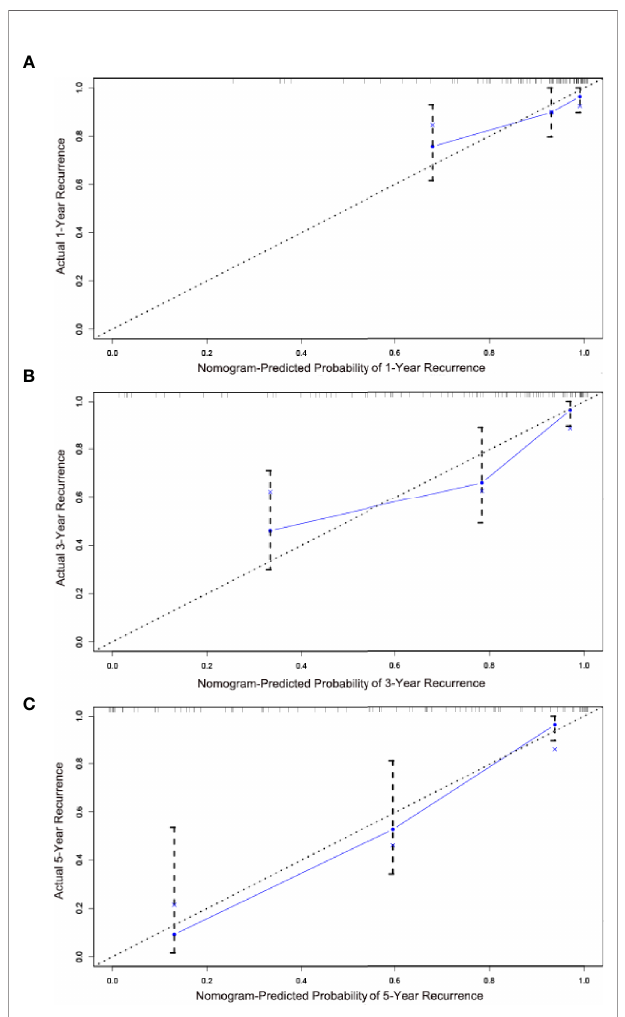
FIGURE 6 | Calibration plots for the nomogram predictions of (A) 1-, (B) 3- , and (C) 5-year IV-RFS in the validation cohort. The nomogram- predicted probability is plotted on the x -axis; actual recurrence is plotted on the y -axis. The gray dotted line represents the ideal curve of the calibration models. The blue broken line demonstrates the actual predictive accuracy, the bootstrap-corrected estimates are visually shown by blue X, and the vertical bars represent the 95%